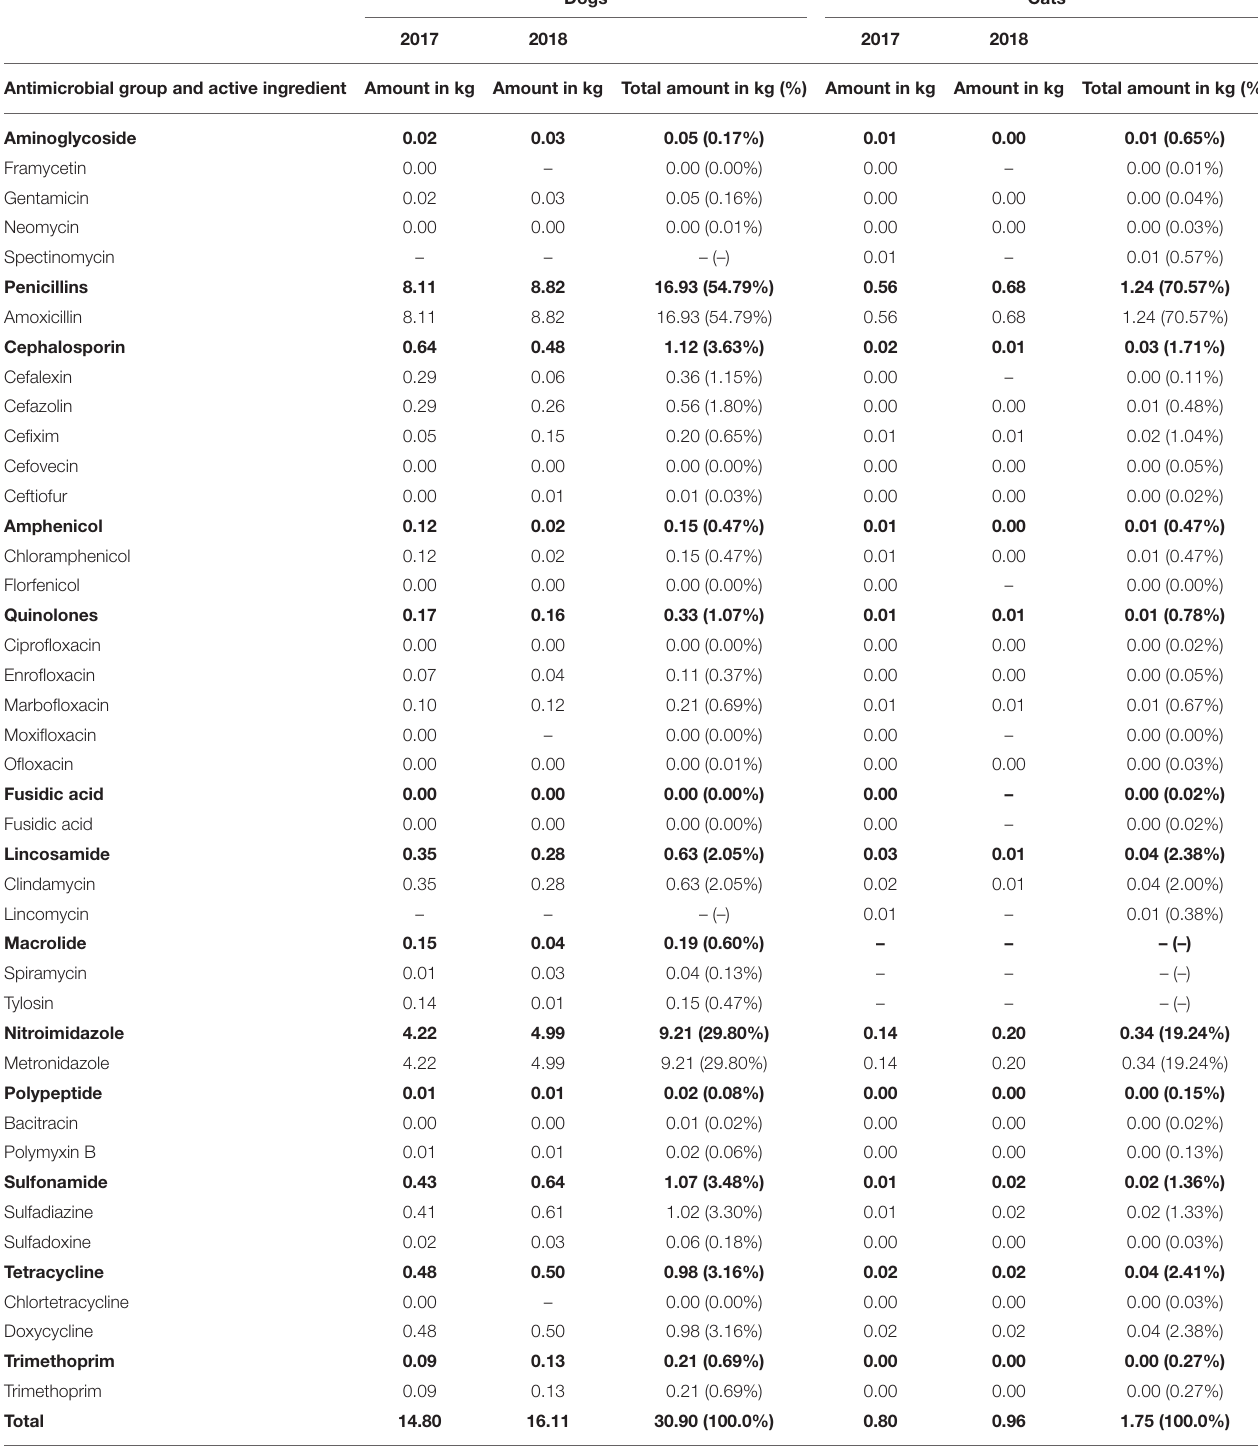
TABLE 3 | Documented amount of antimicrobial active ingredients used in dogs and cats in 2017 and 2018 at the Department of Small Animal Medicine and Surgery, University of Veterinary Medicine